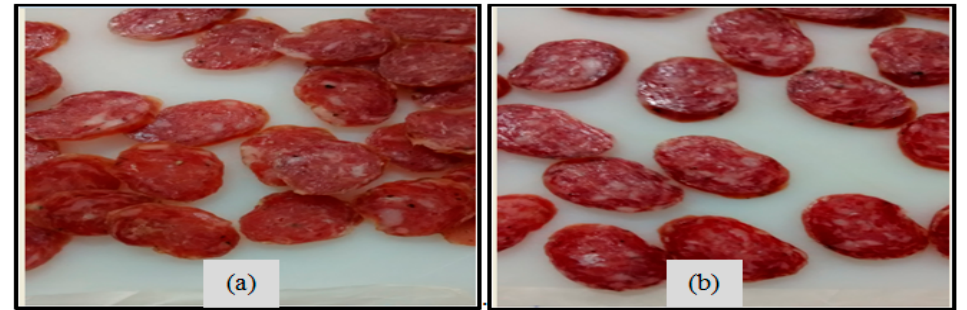
Figure 4. Appearance of ripened pepperoni with commercial culture ( a ) vs. appearance of ripened pepperoni with L. plantarum ATCC 8014 ( b ) propagated on a medium based on the enzymatic hydrolyzate of bovine blood